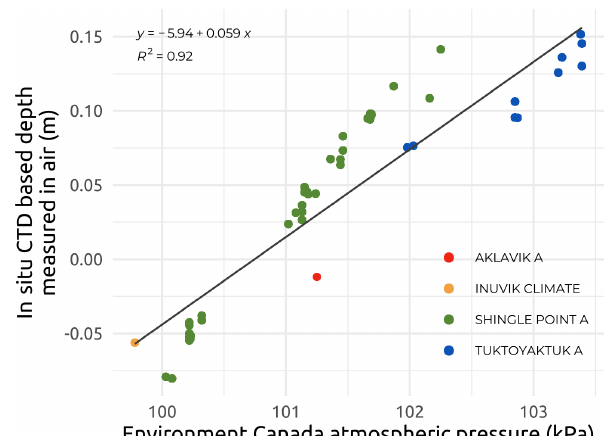
Figure B1. Depth tare correction of in situ, CTD-based depth mea- sured in air against Environment and Climate Change Canada val- ues of atmospheric pressure with linear model fit.